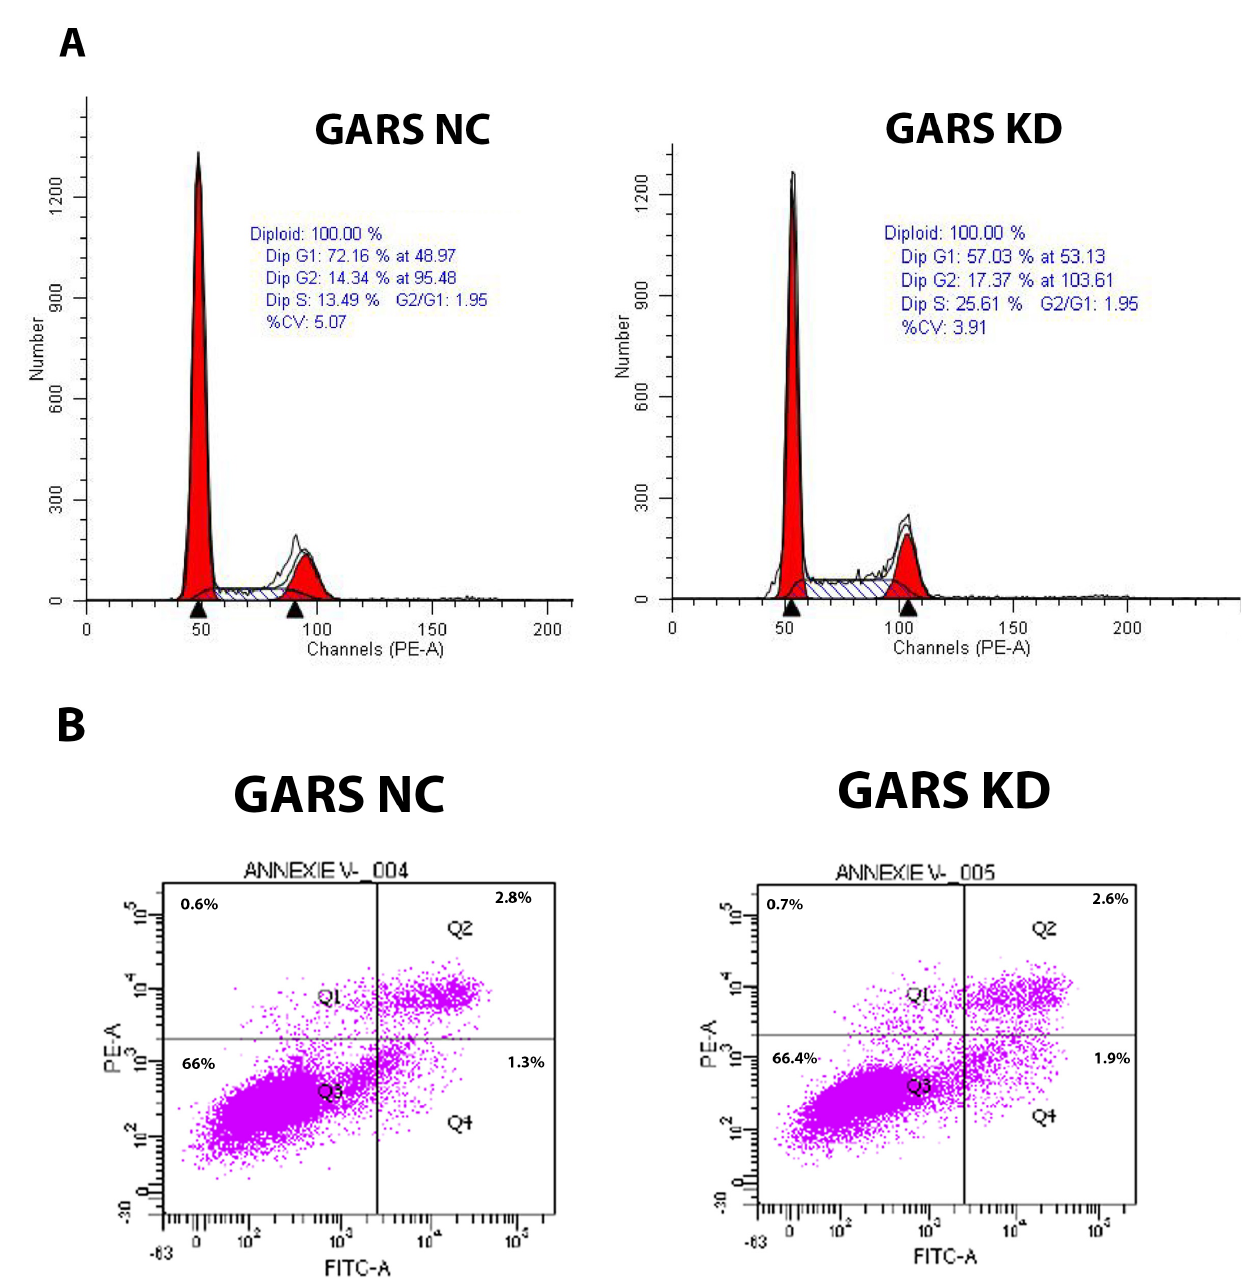
Figure 8. Cell cycle and apoptosis assay analysis post GARS knockdown in PC3 cell line. ( A ) Cell cycle analysis using PI staining (chi square test; p < 0.001). ( B ) Apoptosis analysis using Annexin V. Data analyzed using FACSDiva. Cell cycle using PI staining and apoptosis assays after GARS knockdown (chi square test; p < 0.001 ) . Data analyzed using FACSDiva.